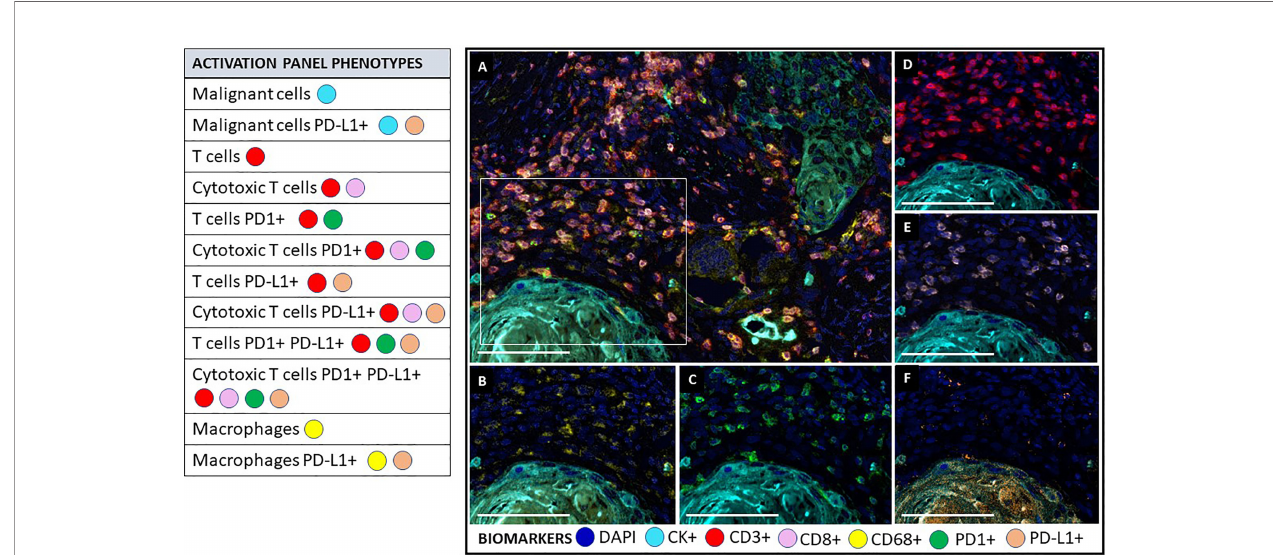
FIGURE 4 | Multiplex immuno fl uorescence activation panel. The activation panel includes a universal biomarker for nuclear detection (DAPI) and cytokeratin for the detection of epithelial cells (malignant cells), which is also helpful for the compartmentalization of the image (tumor vs. stroma). TME and its different immune cell populations are detected using CD3+ for all lymphocytes and co-expressed CD8+ for cytotoxic T cells. Biomarker CD68+ identify macrophage population. This panel also includes biomarker expression for PD1+ and PDL1+ in immune cells and tumor cells to determine their activator or inhibitor status. (A) Composite image of TME from oral squamous cell carcinoma, showing all markers of a multiplex immuno fl uorescence “ activation panel ” , activated simultaneously. (B) Composite image showing CD68 positive expression (yellow) of immune cells in the stromal compartment. (C) Composite image showing PD1 positive expression (green) of immune cells in the stromal compartment. (D) Composite image showing CD3 positive expression (red) of immune cells in the stromal compartment. (E) Composite image showing CD8 positive expression (pink) of immune cells in the stromal compartment. (F) Composite image showing PD-L1 positive expression (orange) of immune cells in the stromal compartment. inForm ® image analysis software, Akoya bioscience (scale bar: 100 m m). Scanner Vectra Polaris. DAPI (blue-DAPI), cytokeratin (cyan-opal 620), CD3+ (red-opal 690), CD8+ (pink-opal 540), CD68+ (yellow-opal 520), PD1+ (green-opal 650), PD-L1+ (orange-opal